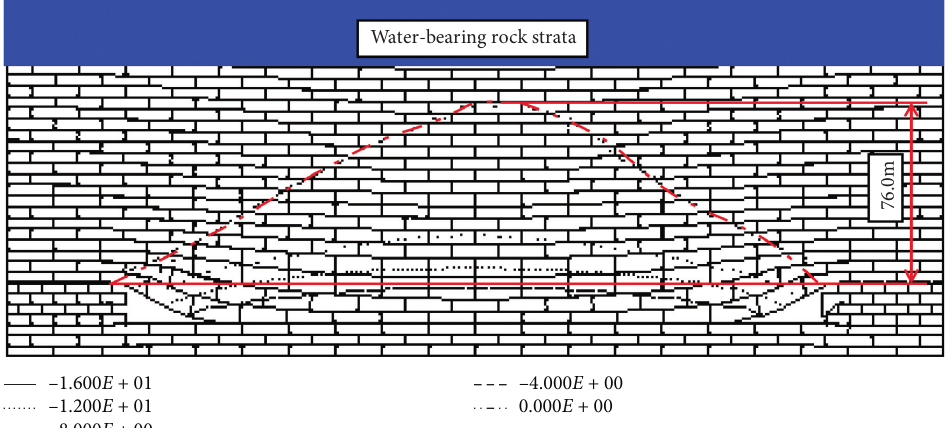
Figure 10: Caving and displacement evolution trend of overlying strata in all coal